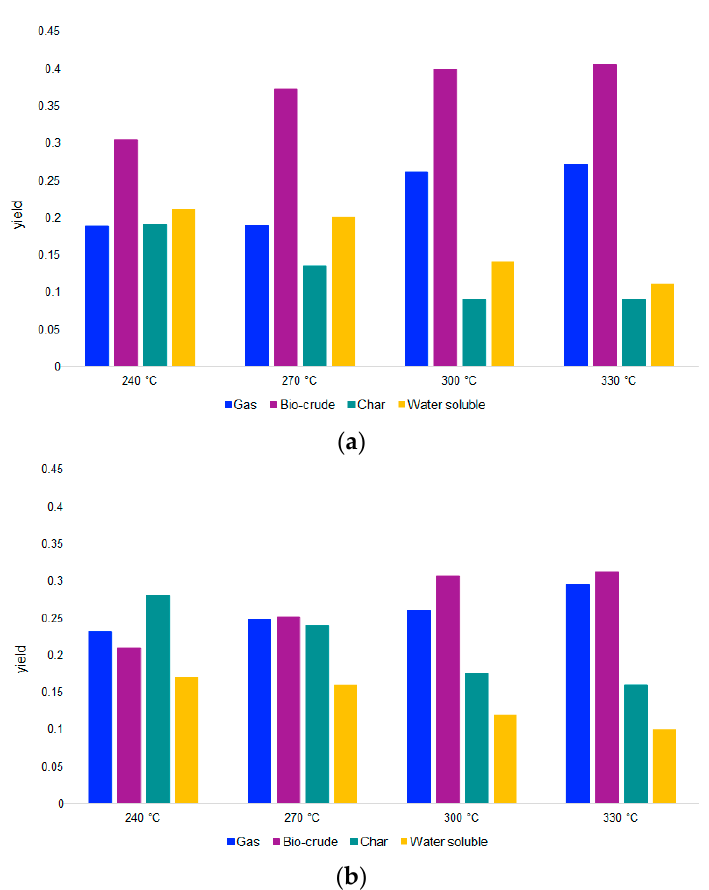
Figure 2. Effect of temperature on the products distribution in HTL of ( a ) BS and ( b ) BM. The tests were performed at a constant reaction time of 60 min.